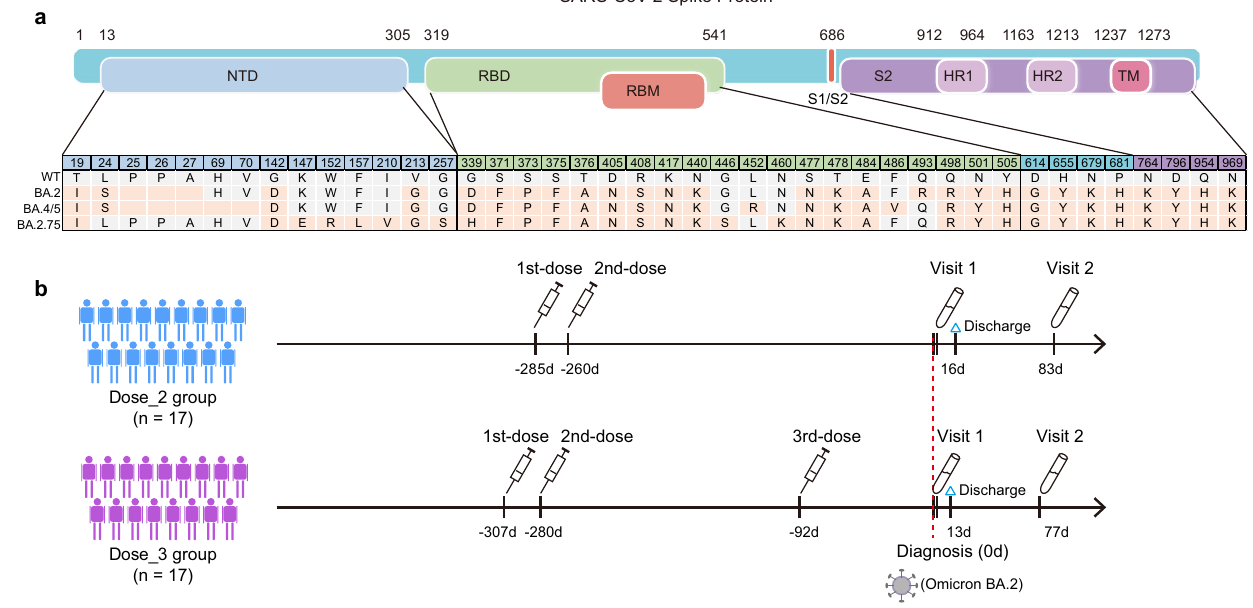
design. Blood samples from BA.2 breakthrough infected individuals previously immunized with 2-dose or 3-dose inactivated vaccines were collected in the early stageofinfection(Visit1,within2daysafterdiagnosis)andduringtheconvalescent period (Visit 2, 81 days post